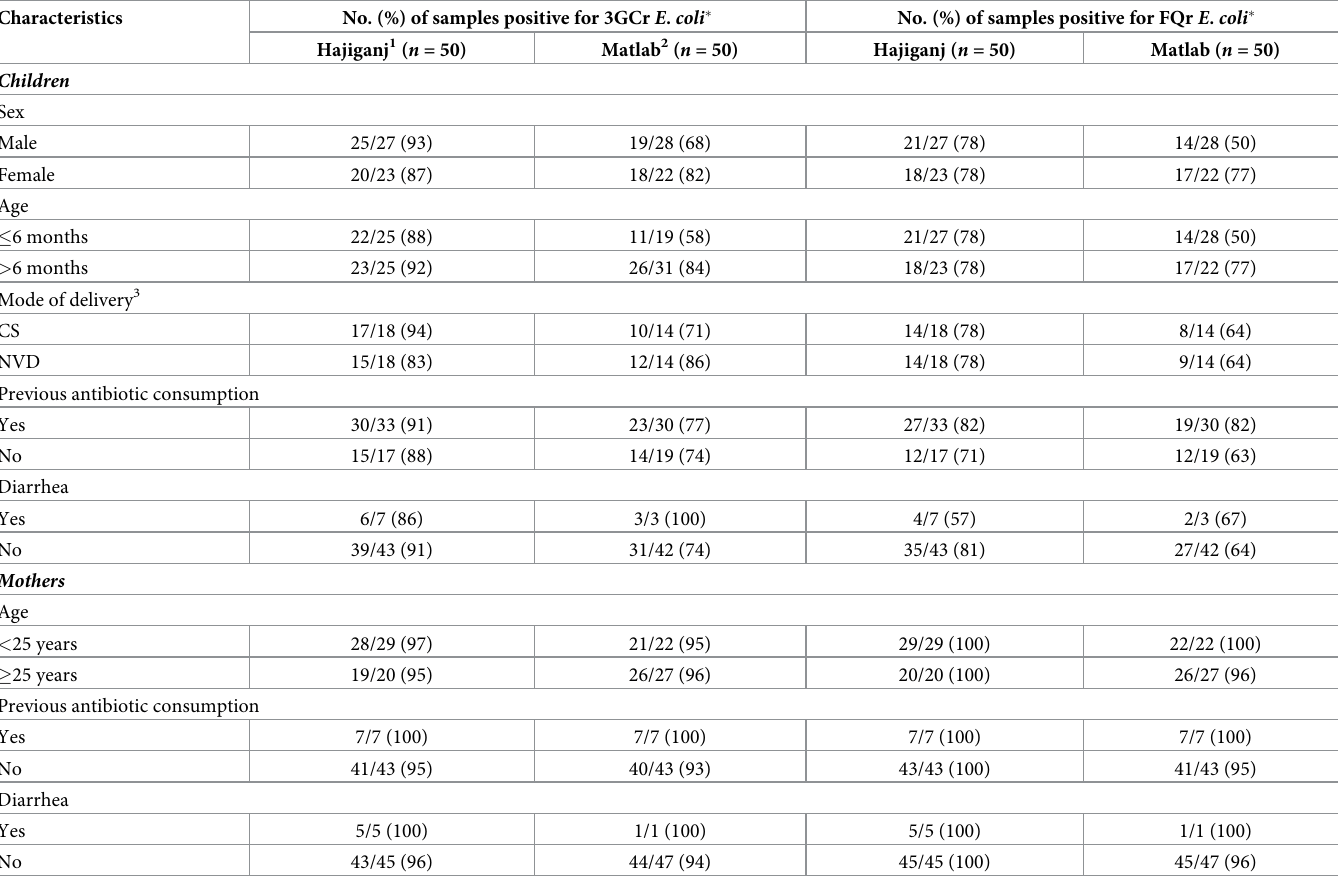
Specifically, the gut microbiome during childhood has a long-lasting effect on overall health in adulthood. Moreover, gut colonization with ARO increases the risk of drug-resistant infec- tions, including urinary tract and bloodstream infections and neonatal meningitis [47–49]. Additionally, gut colonization with ARO represents a gene pool for antimicrobial resistance genes that can be exchanged with other human pathogens in the gut. Table 5. Demographic characteristics of children and mothers colonized with third-generation cephalosporin-resistant (3GCr) or fluoroquinolone-resistant (FQr) E . coli in areas with and without arsenic exposure through drinking